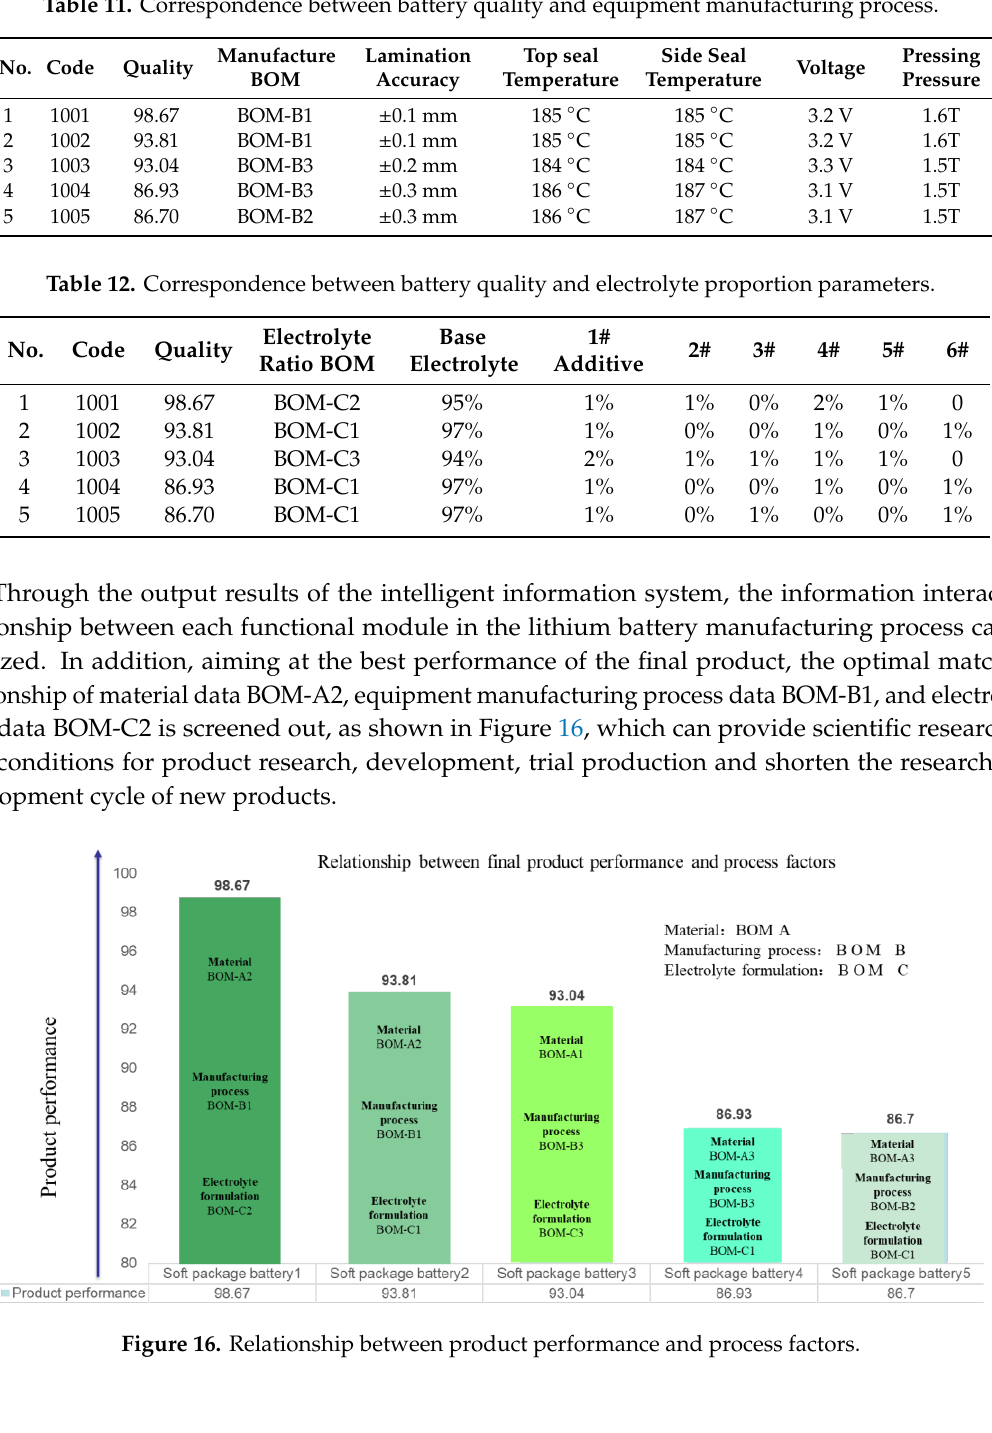
Table 11. Correspondence between battery quality and equipment manufacturing process.